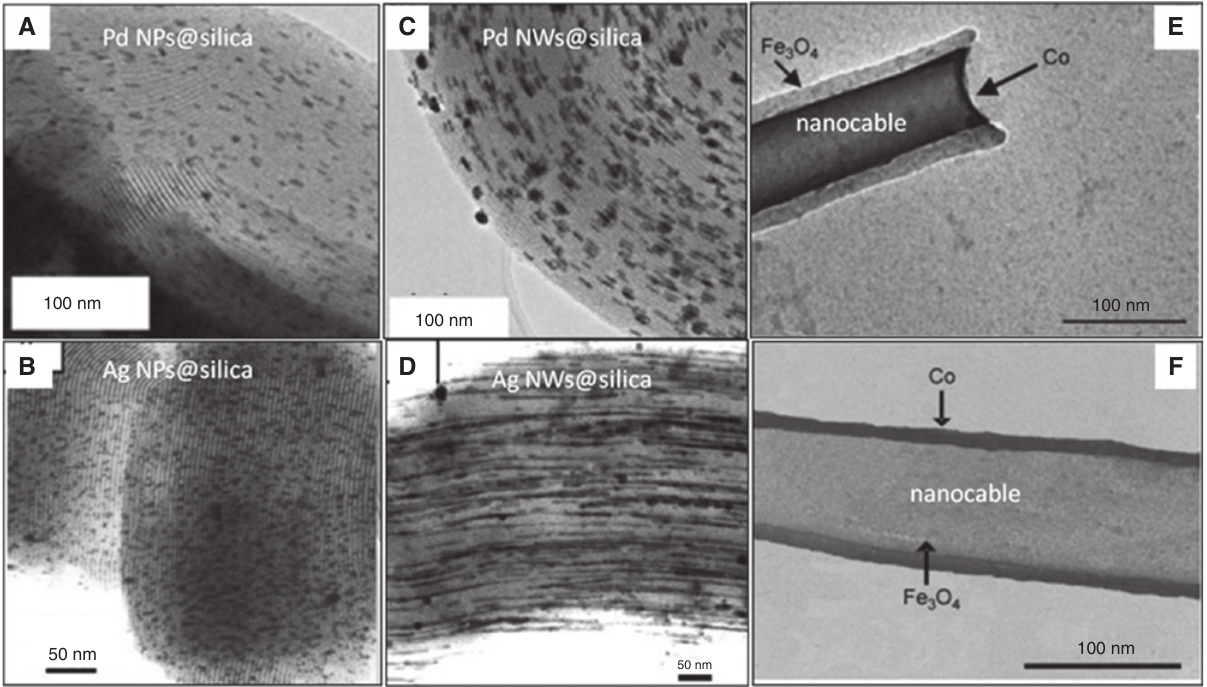
Figure 7: Mesoporous silica filled with NPs of Pd (A) and Ag (B) at lower precursor concentration; increasing the metal loading, nanowires of Pd (C) and Ag (D) are formed within the pores. Reprinted with permission from Aschenbrenner O, Kemper S, Dahmen N, Schaber K, Dinjus E, J. Supercrit. Fluids 2007, 41, 179–186 [53], Copyright 2007 Elsevier; and from Zhao J, Yu H, Liu Z, Ji M, Zhang L, Sun G, J. Phys. Chem. C 2014, 118,